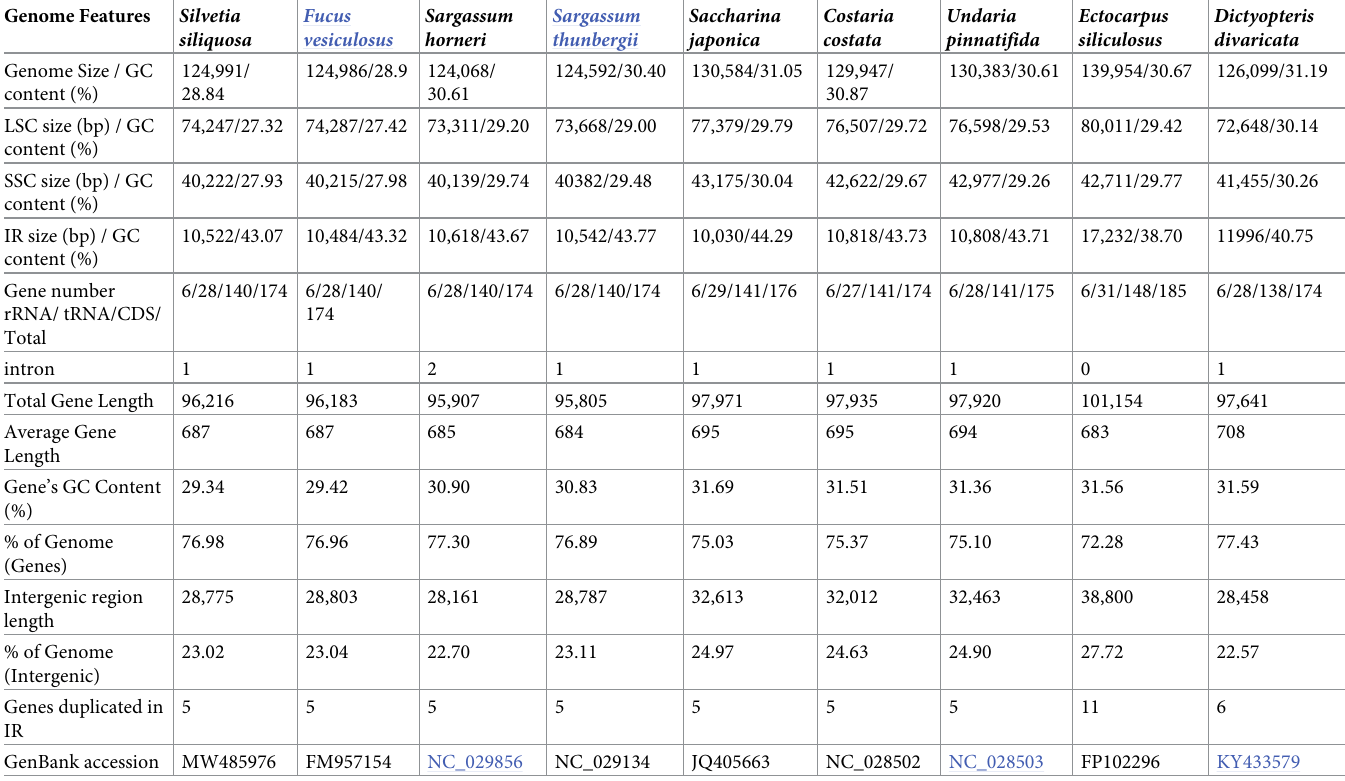
Table 2. General features of chloroplast genomes in Phaeophyceae. Genome